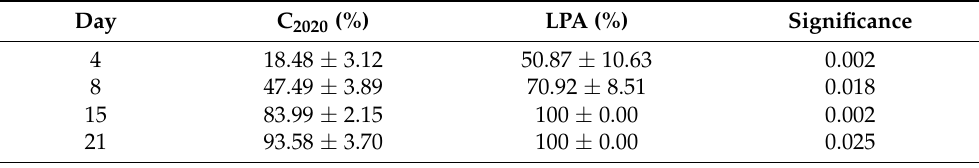
Table 2. Statistical analysis of the percentage size reduction of the wounds during the healing pro- cess for C 2020 and LPA, both made in triplicate.